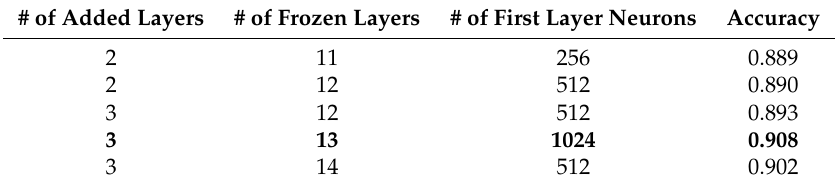
Table 3. Some tests on fine-tuning with VGG19 topology and relative accuracy values. The best choice of parameters in terms of validation accuracy is highlighted in boldface